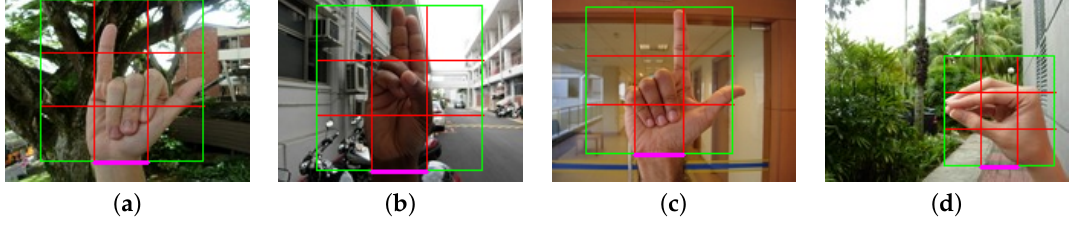
Figure 5. Examples of annotations in the